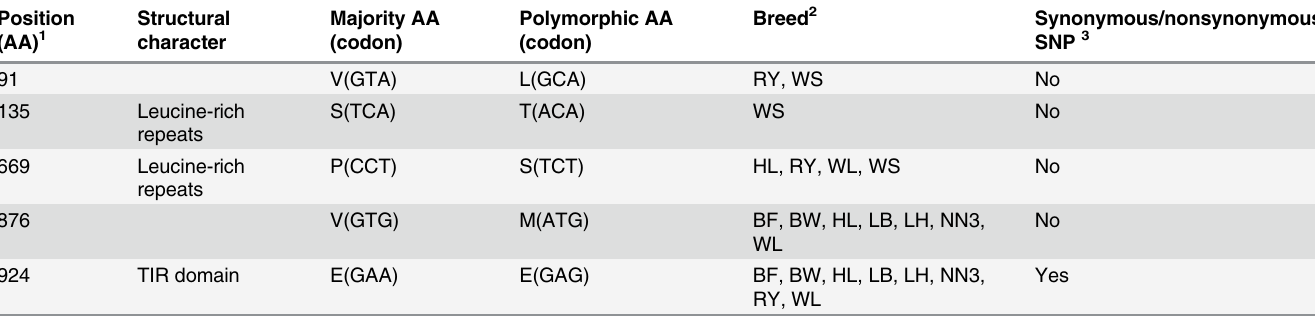
Table 2. Chicken TLR7 polymorphic sites in different